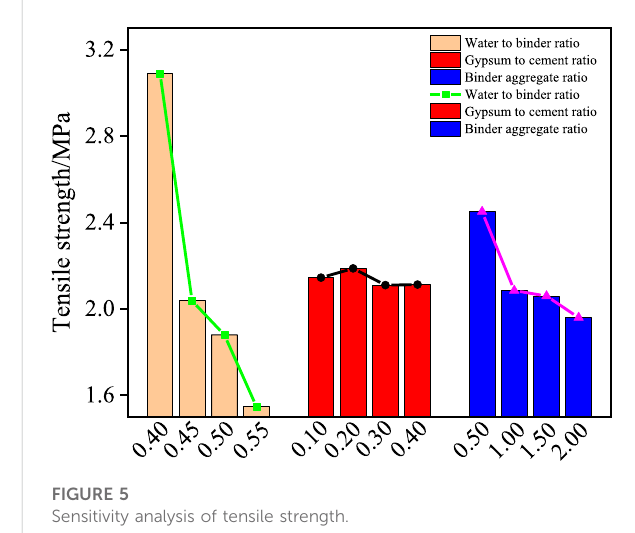
FIGURE 5 Sensitivity analysis of tensile